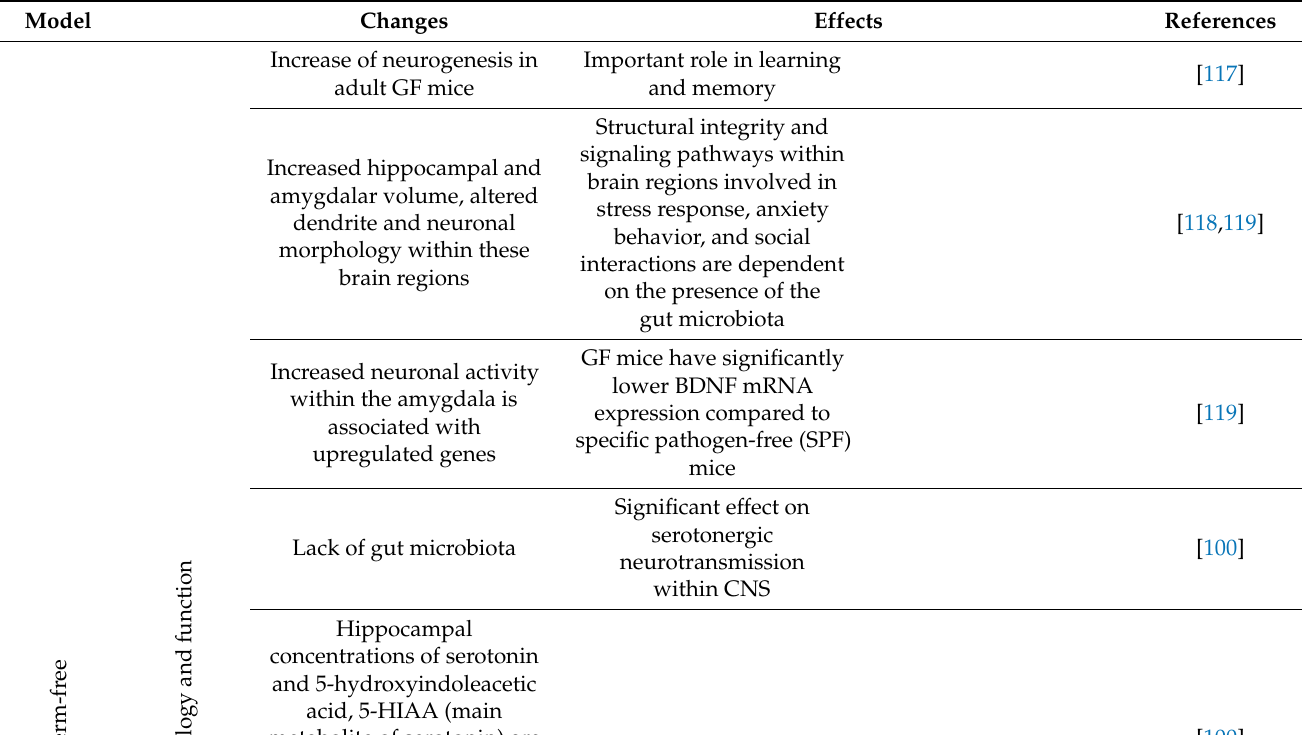
Table 2. The alterations of the key models affecting brain physiology and function as well as behavioral profiles, cognitive function, and stress responses in